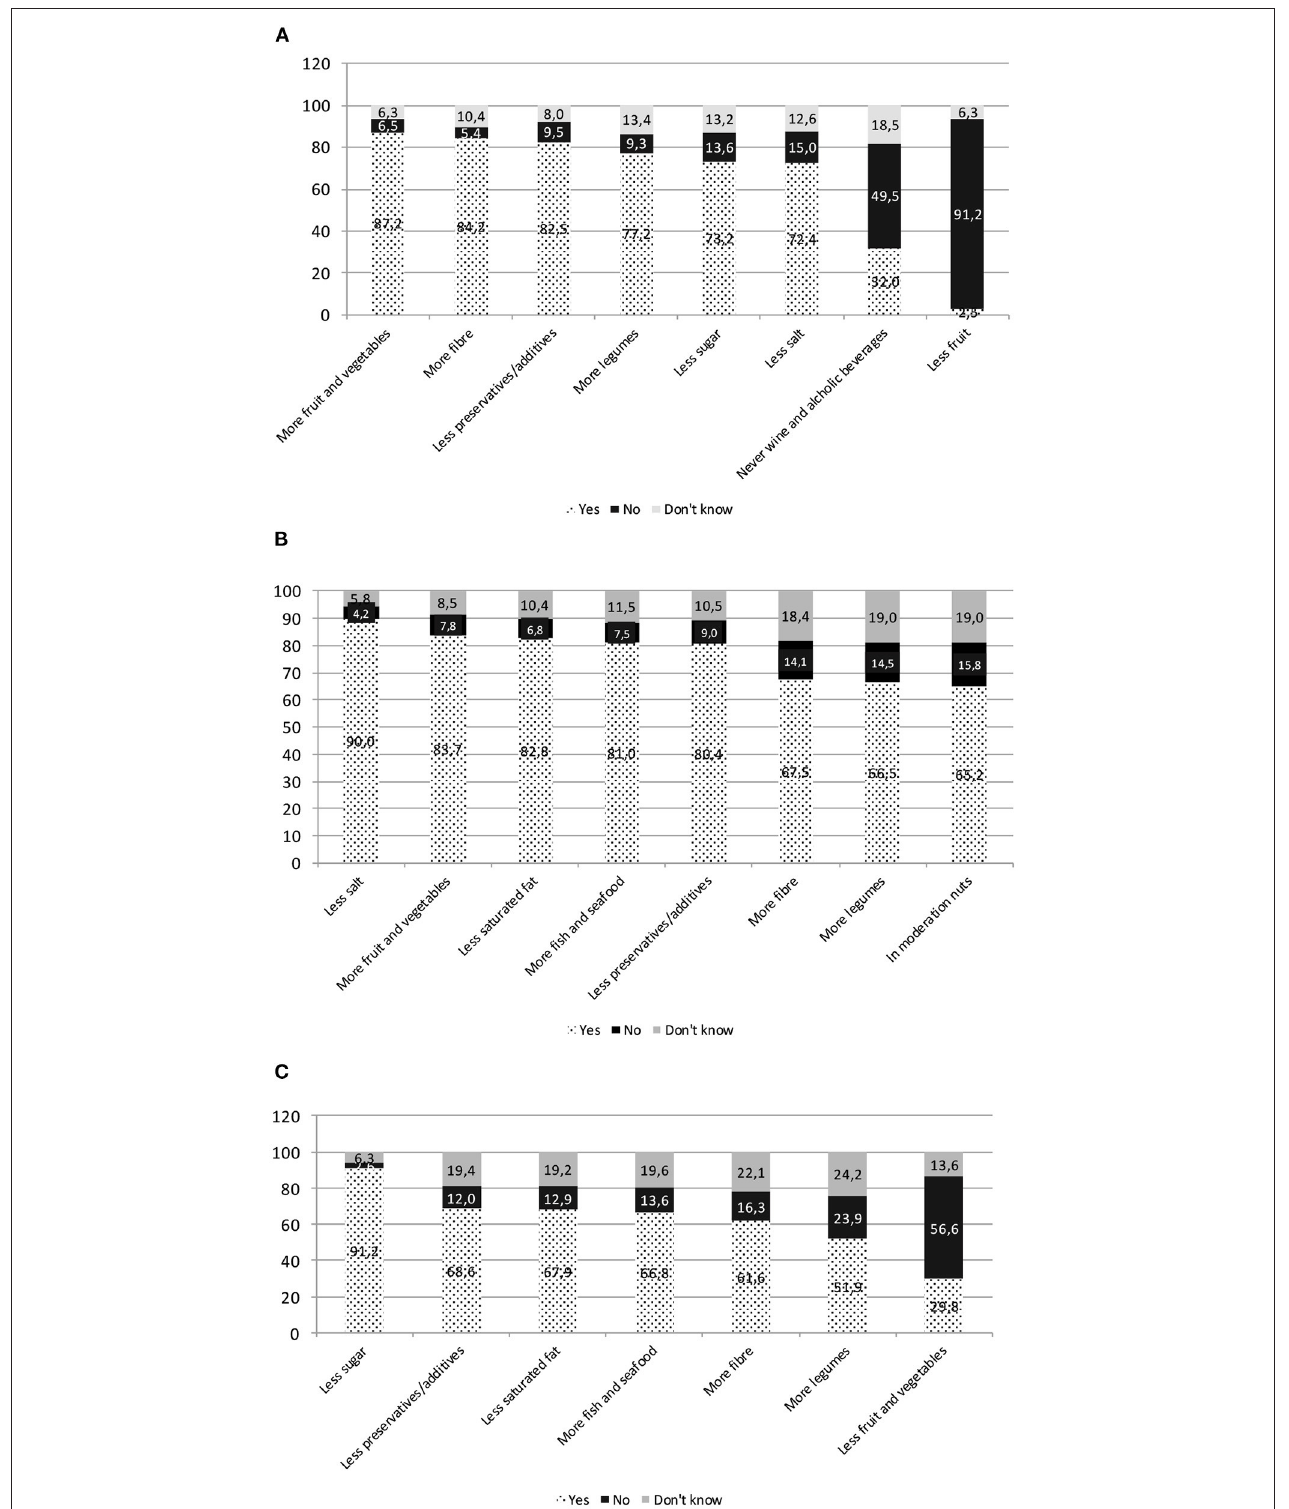
FIGURE 3 | NK3 diet–disease relationship. (A) Food intake helping to reduce the chance of getting certain kinds of cancer. (B) Food intake helping to prevent heart disease. (C) Food intake helping to prevent diabetes.